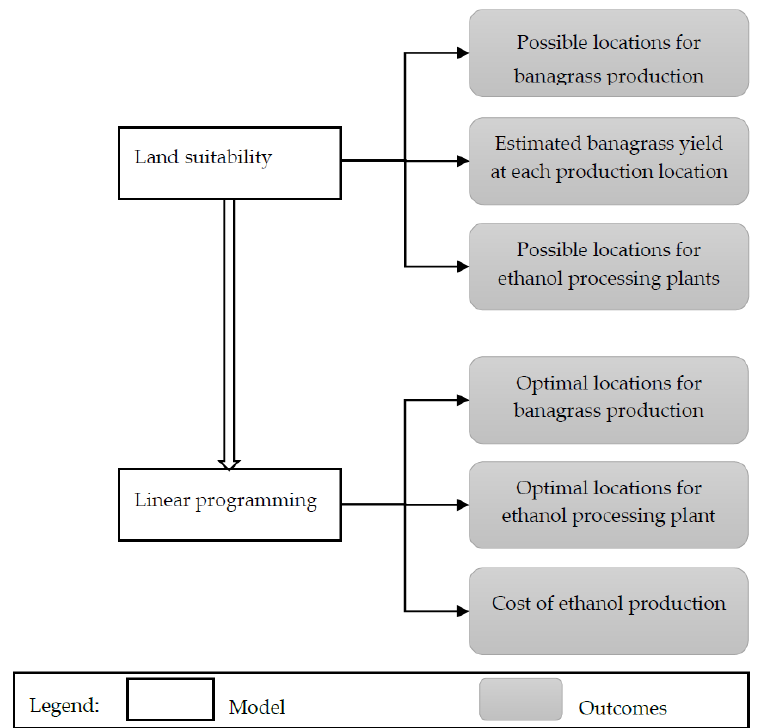
Figure 2 : Methodological flowchart. Figure 2. Methodological